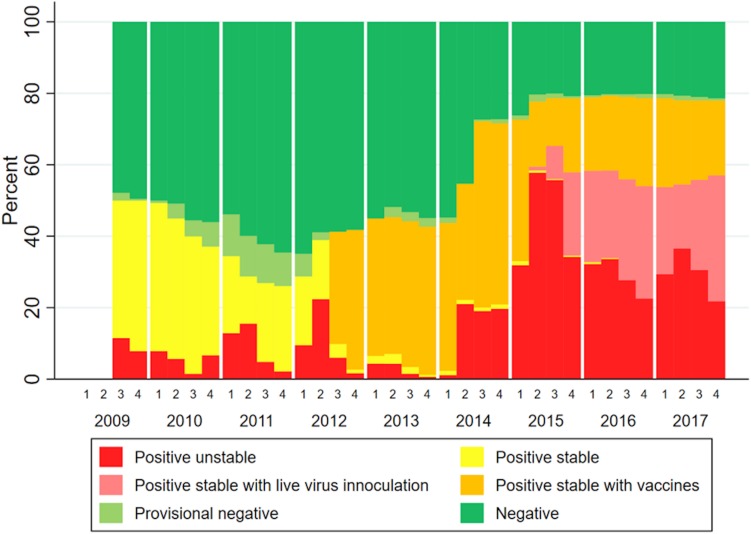
Infection status of farms in the study area over time (quarters and years).